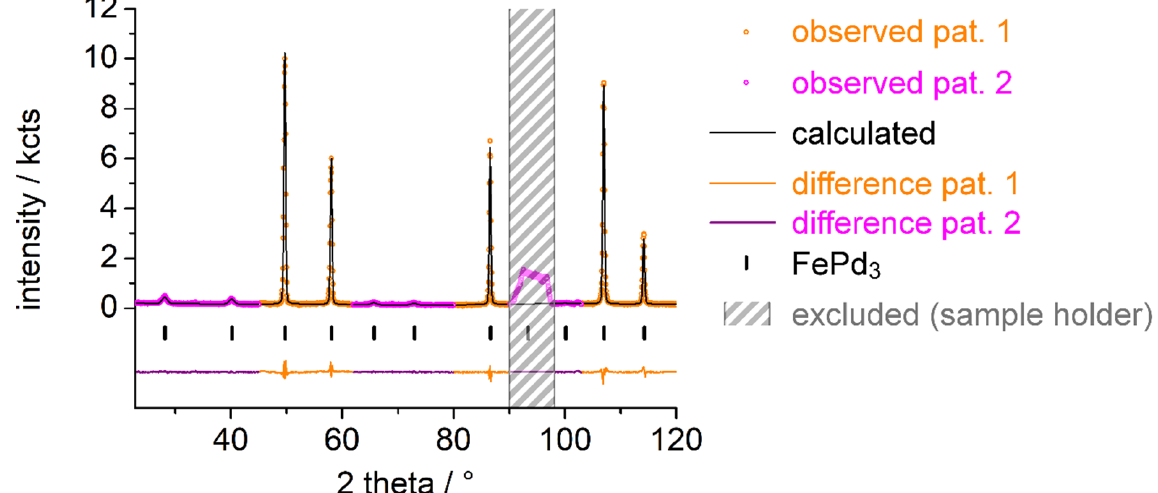
Figure A9. Rietveld refinement of the crystal structure of FePd 3 D 0.013(8) (for details, see second row in Tables A6 and A7) based on neutron powder diffraction data (NUMOR 131629 [21], λ = 186.80(2) pm, D20 ILL, Grenoble) in a single-crystal sapphire cell at 296(1) K and 0.50(1) MPa deuterium pressure using FullProf [24].